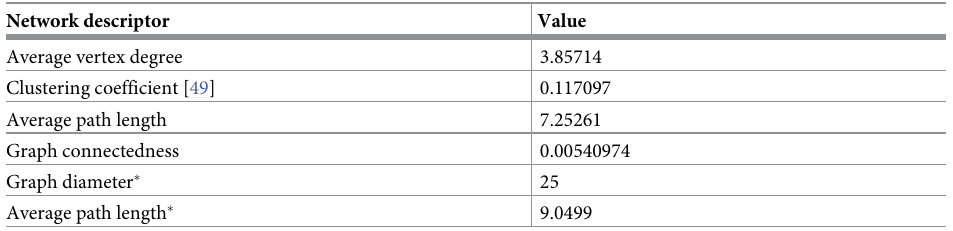
Table 1. Network descriptors of neutral network of